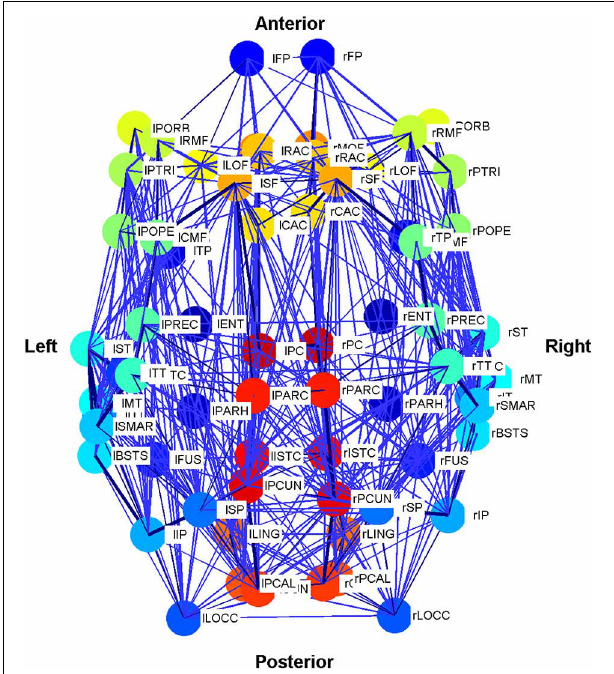
FIGURE 3 | Schematic plot (top view) of the Cabral human brain model showing the connections and connection weights between oscillators which correspond to different brain regions. The weight of the connection lines represent the strength of connectivity between the oscillators. The darkest blue lines are the strongest 1% of connections. The node colors represent oscillators, which model different brain regions as detailed in Cabral et al. (2011). Colors are consistent for homologous regions in the left and right hemispheres. Anterior and posterior, left and right are